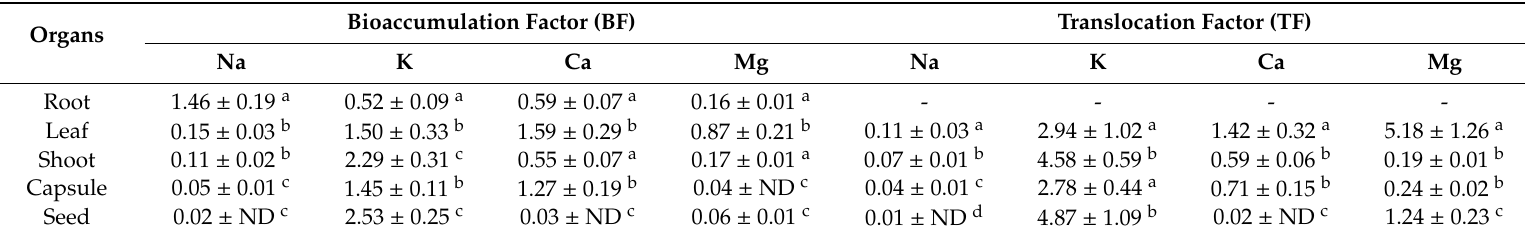
Table 4. Bioaccumulation factor and translocation factor in di ff erent organs of wild